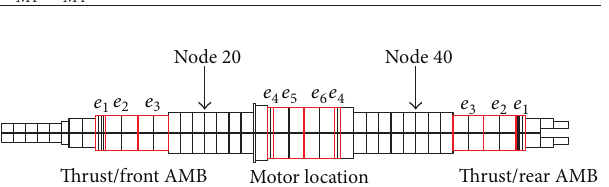
Figure 6: FE rotor model indicating locations of the 6 moduli of elasticity design